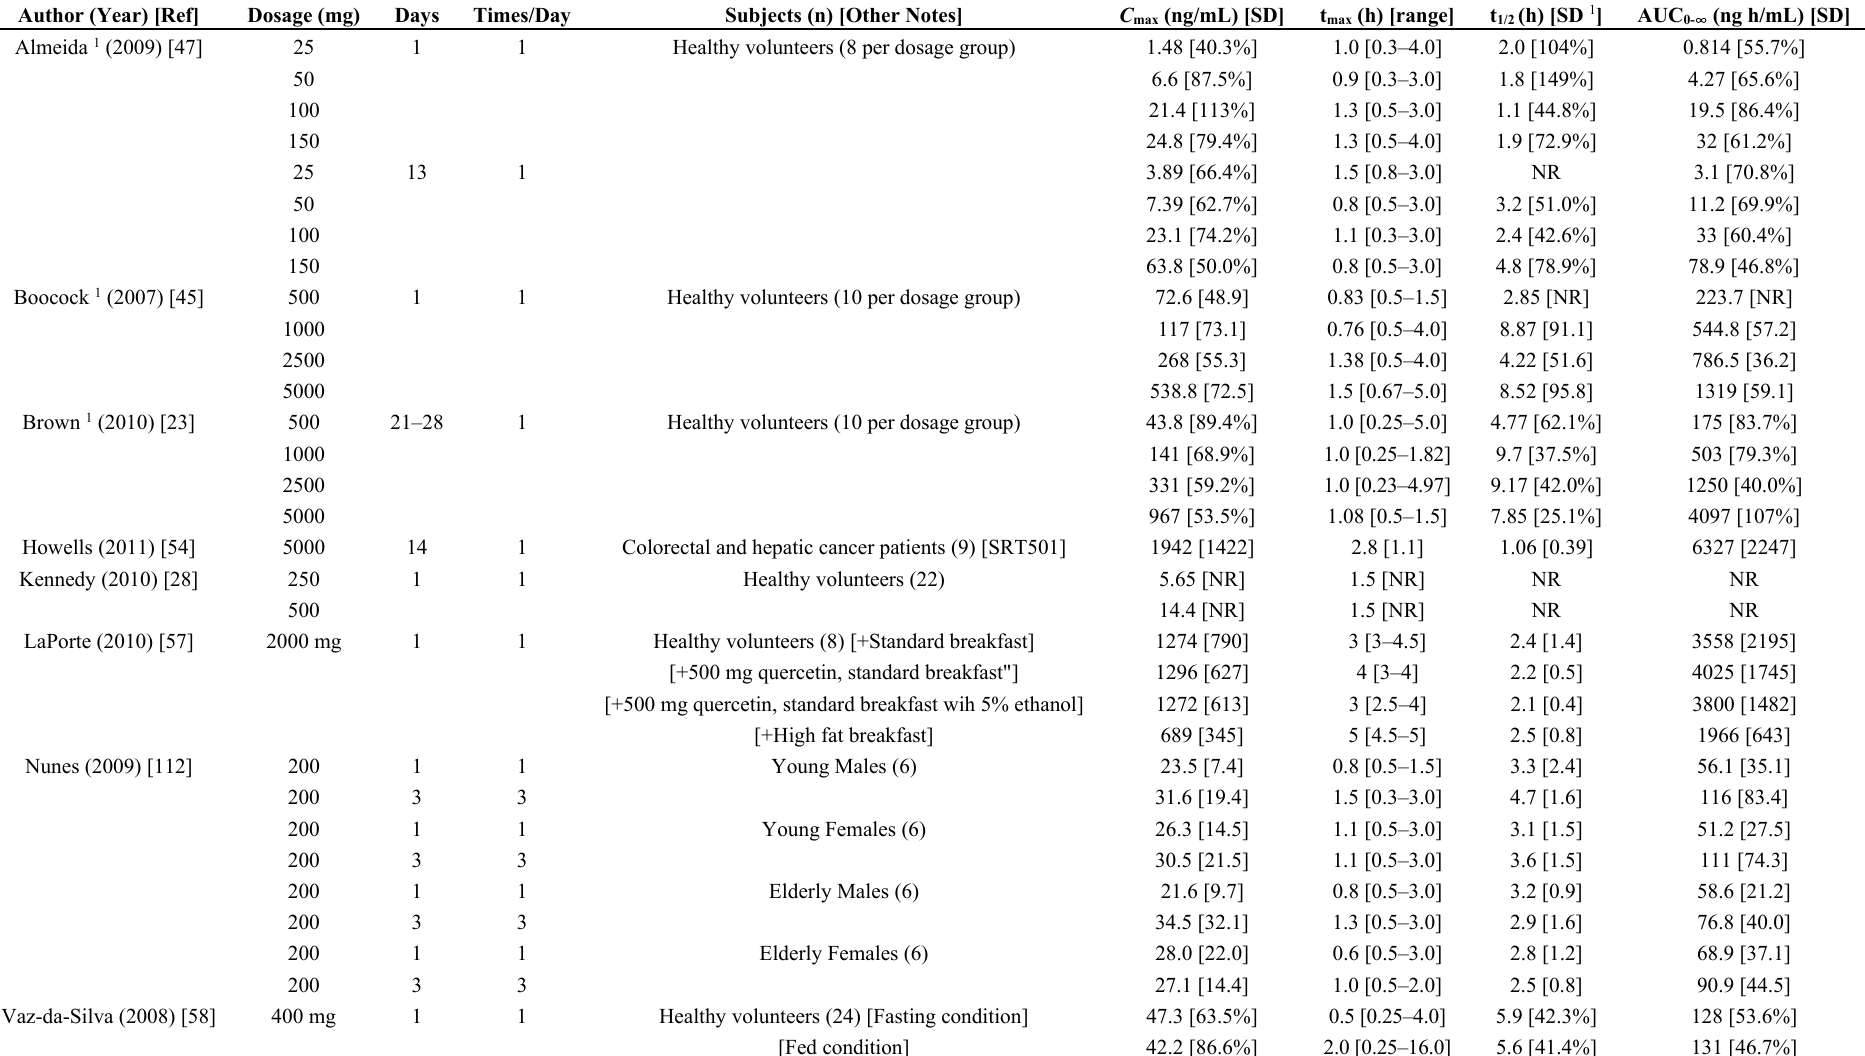
Table 1. Summary of key bioavailability parameters of free trans -resveratrol in humans following oral supplement